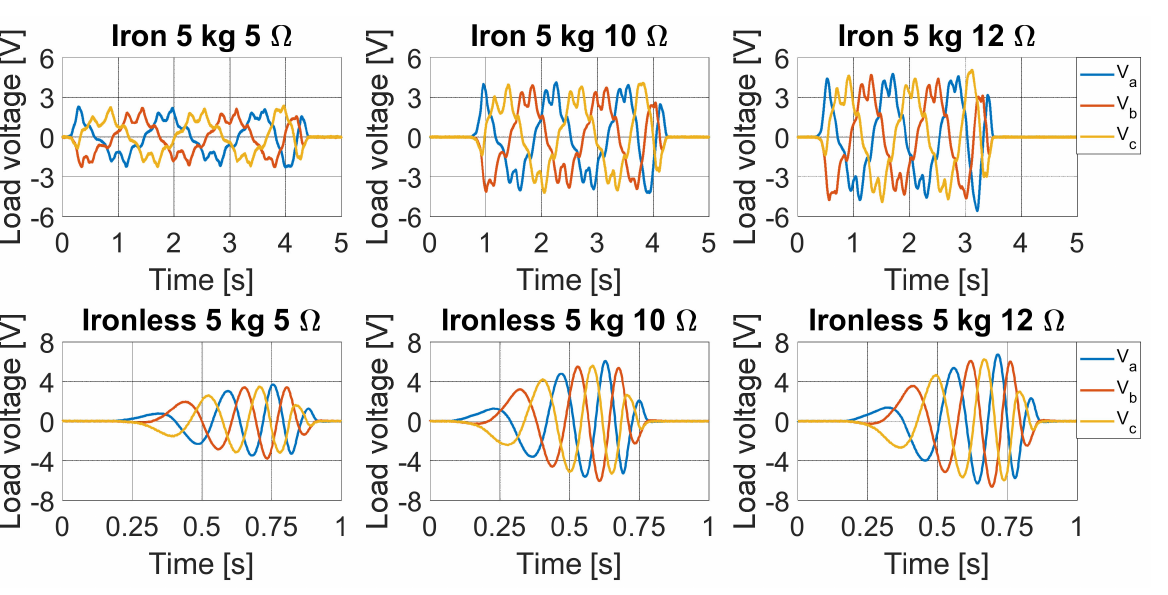
Figure 11. Load voltages trends of the 5 kg test with a resistance load equal to 5 Ω , 10 Ω and 12 Ω .